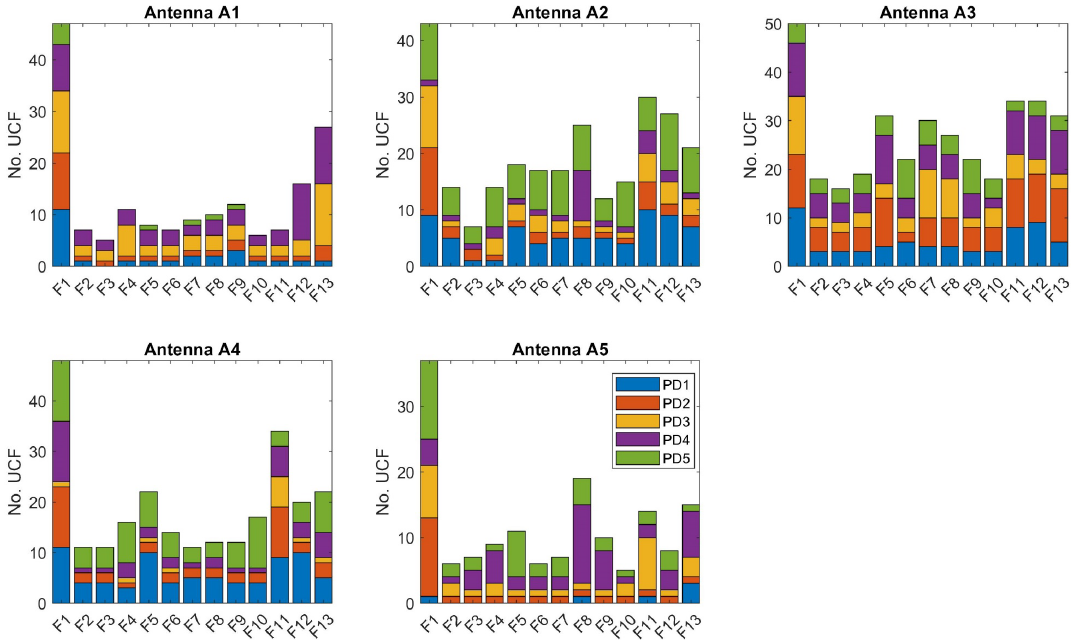
Figure 7. The number of times a given feature was uncorrelated (no UCF) with another: | r | < 0.3.